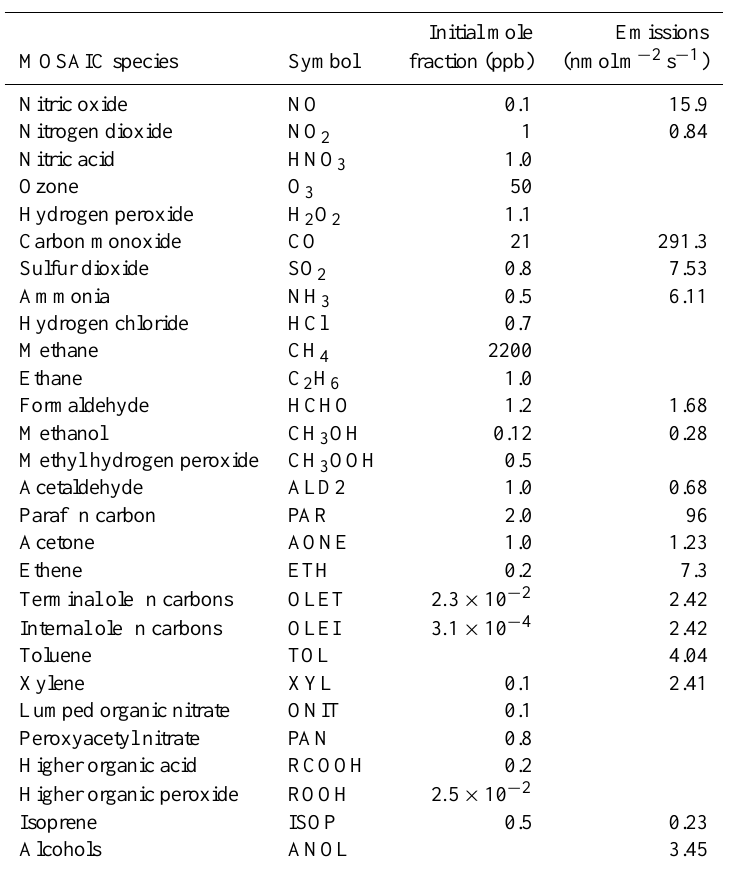
Table 2. Gas-phase initial conditions and emissions for baseline